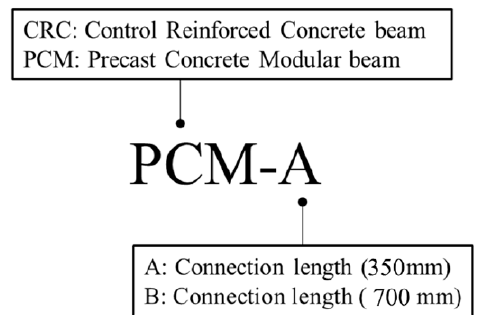
Figure 5. Notation of specimens.